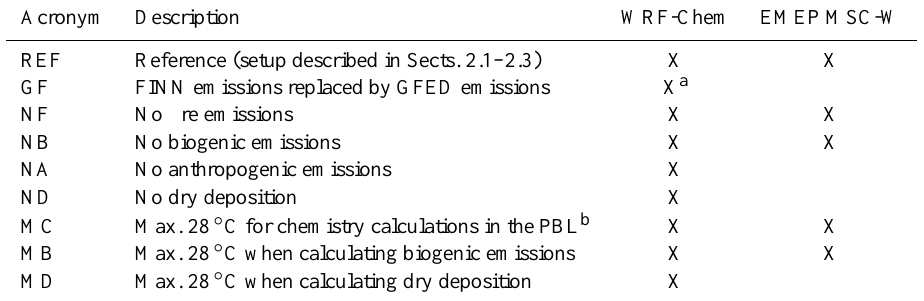
Table 3. Overview of the model simulations performed by each of the two models. The WRF-Chem simulations include only gas-phase chemistry, while the EMEP MSC-W simulations include also aerosol